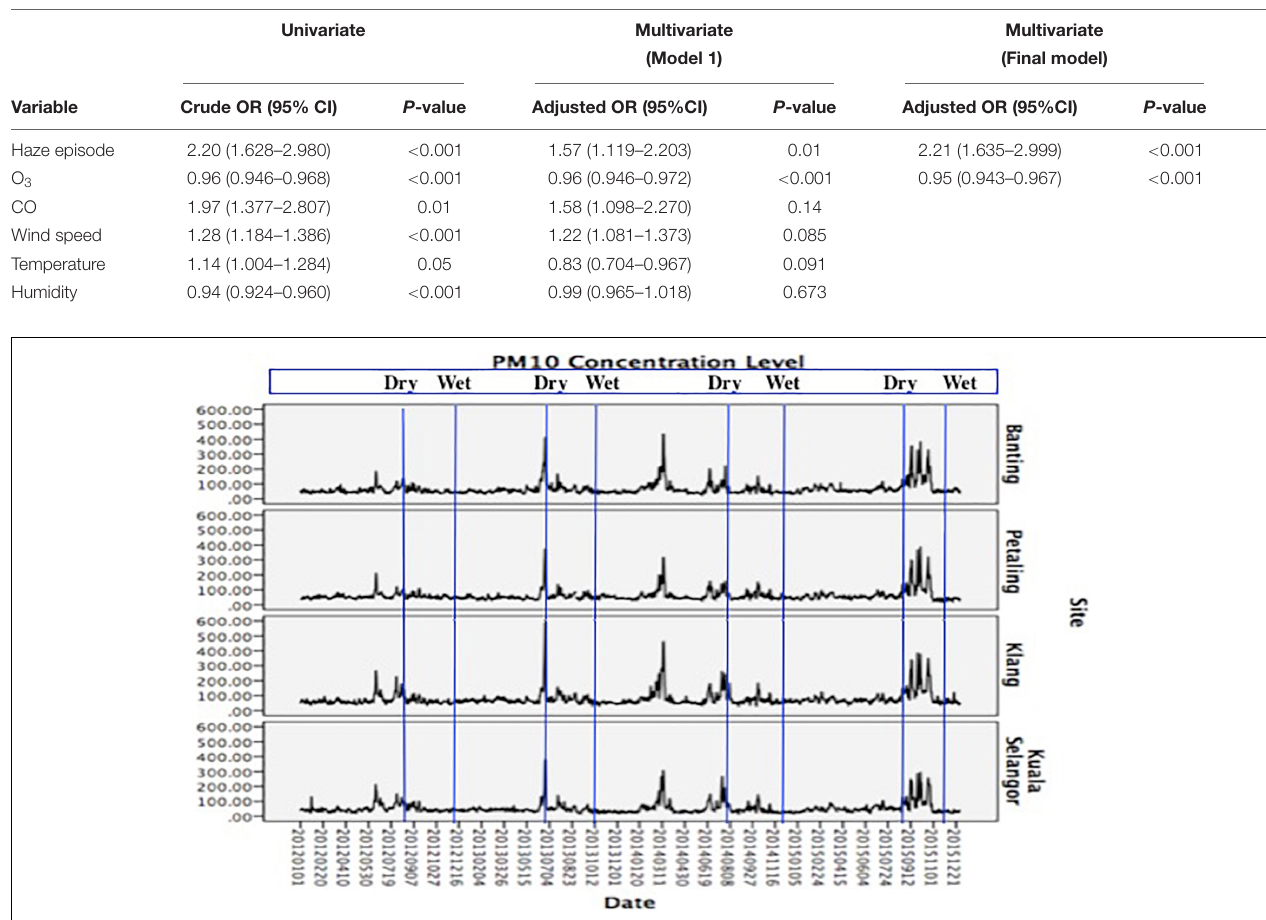
FIGURE 2 | Trend of PM 10 ( µ g/m 3 ) level in Selangor